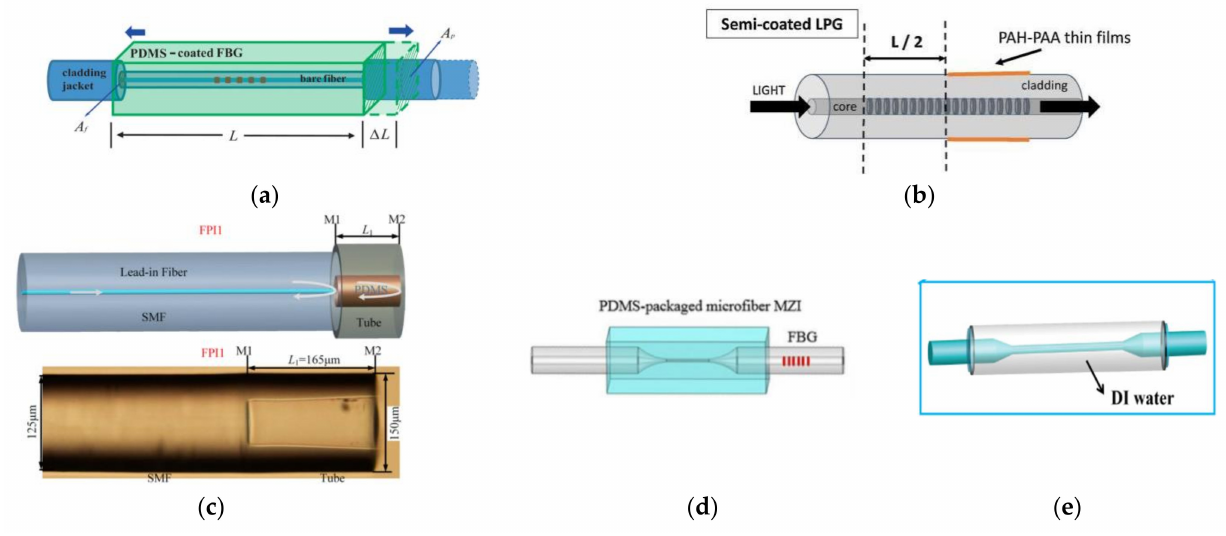
Figure 7. Schematic diagram of ( a ) PDMS-coated FBG [126]. ( b ) Semi-coated FBG [127]. ( c ) Encapsu- lation method of FPI sensors [131]. ( d , e ) Encapsulation method of MMZI sensors